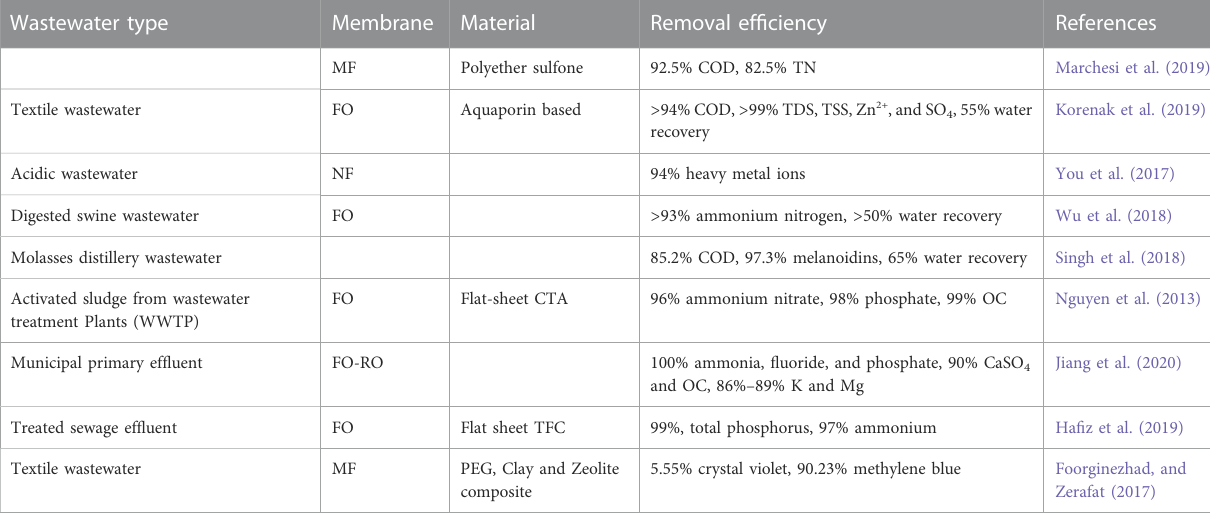
TABLE 1 Different membrane technologies with their removal ef fi